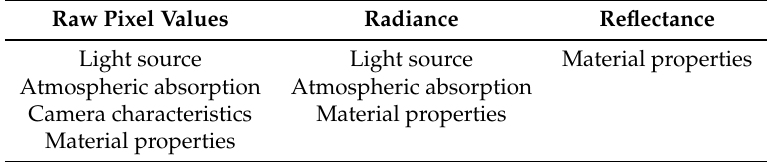
Table 2. Factors affecting quantities obtained from passive hyperspectral camera